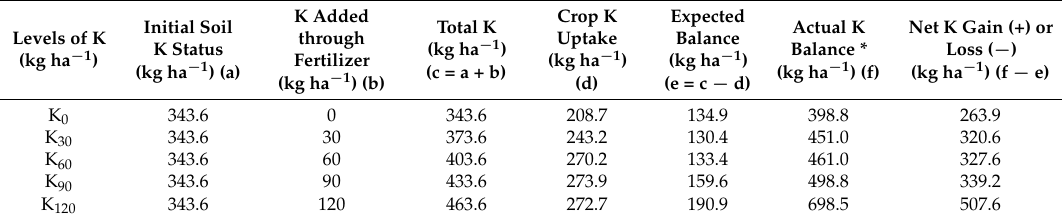
Table 6. Potassium balance in soil after harvesting of hybrid rice (var. Arize 6444) as influenced by potassium fertilization (means for 2016 and 2017).